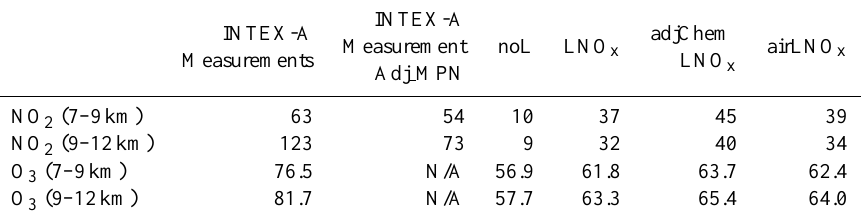
Table 5. Mean 7–9km and 9–12km mixing ratios of NO 2 and ozone from 16 DC-8 flights during INTEX-A. Measurements are compared with CMAQ simulations noL, LNO x , adjChemLNO x , and airLNO x . Description of measurements and units are given in Table 4. INTEX-A INTEX-A adjChem Measurements